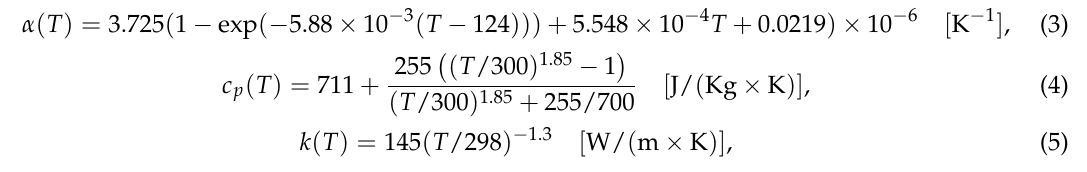
Figure 1. Material orientation of the local x 1 , x 2 axes with respect to the wafer [100]